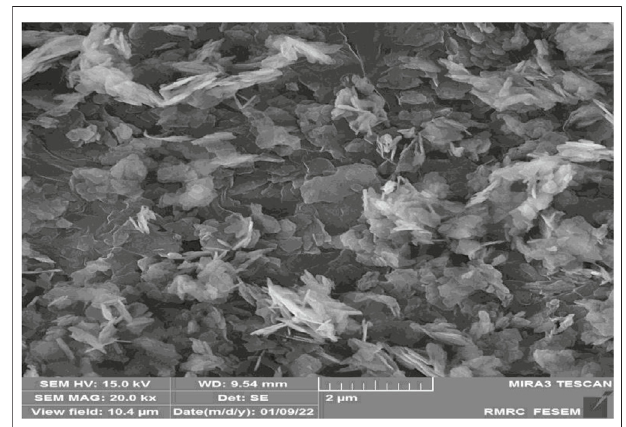
FIGURE 3 | SEM image of Y-MOF synthesized under the optimal condition of the microwave